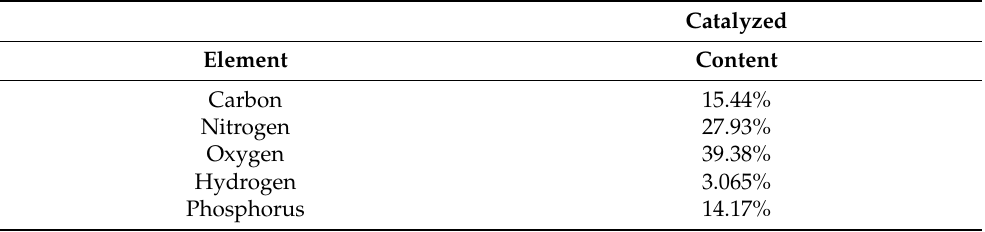
Table 1. Elemental Analysis of Solvothermal Reaction Urea + P 2 O 5 catalyzed by Zn.